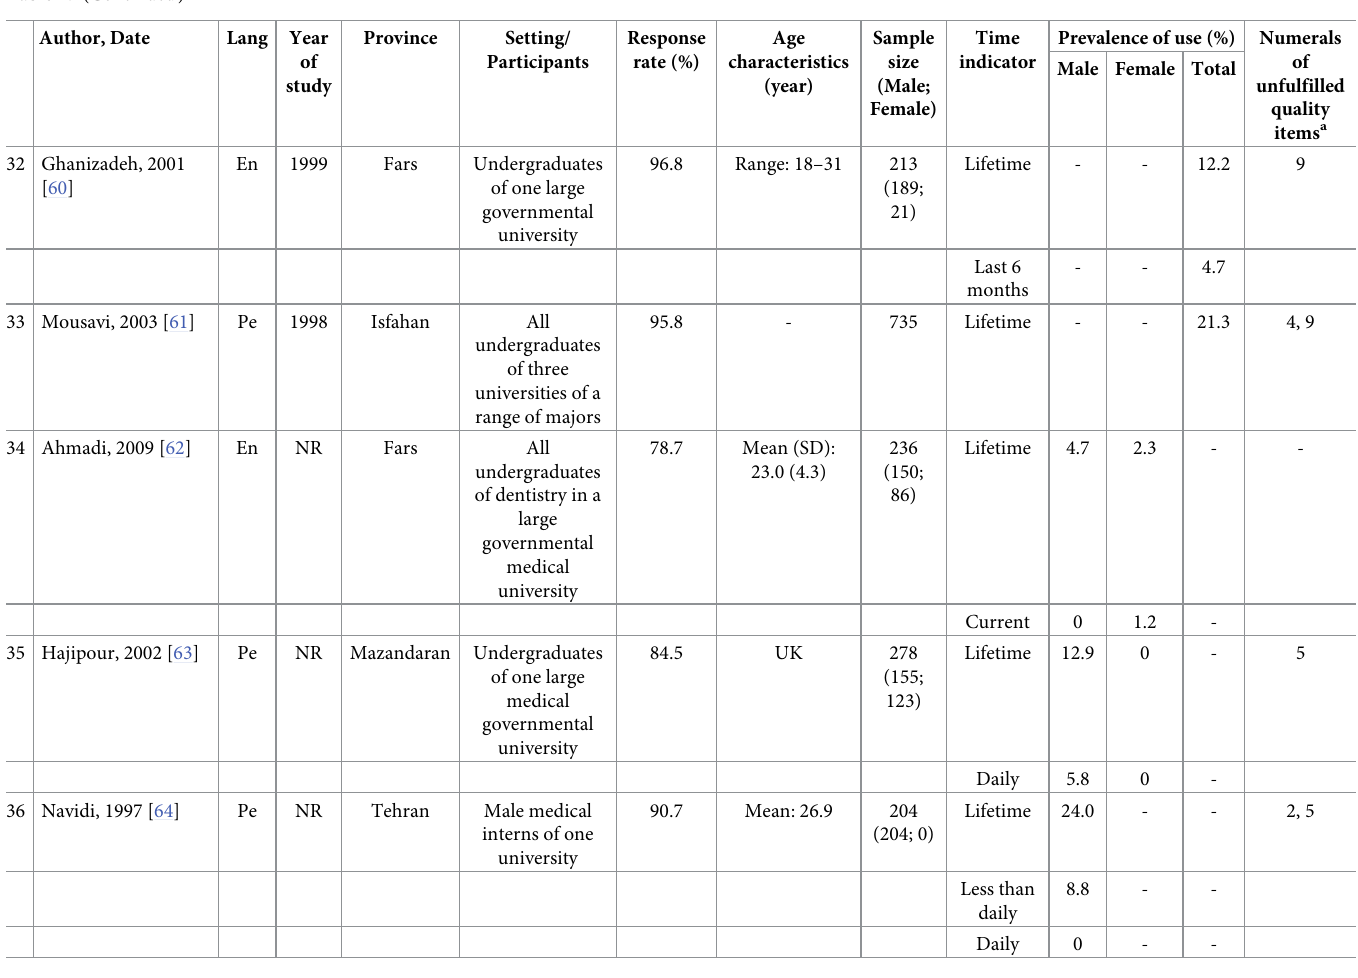
provinces [27]; each round has been presented separately in the relative table and figure. The recruitment settings of included studies were household, street or public places. In the male subgroup, the pooled prevalence estimates were 7.7% (95%CI: 4.5–11.8; I 2 = 97.6%; 6 studies) for lifetime cannabis use, 3.8% (95%CI: 2.2–5.9; I 2 = 92.7%; 2 studies) for last-12 month use and 0.8% (95%CI: 0.04–2.1; I 2 = 2.7%; 2 studies) for last month or current use (Table 5 and S3 Fig). Among the female subgroup, the corresponding estimates were 0.7% (95%CI: 0.04–1.8; I